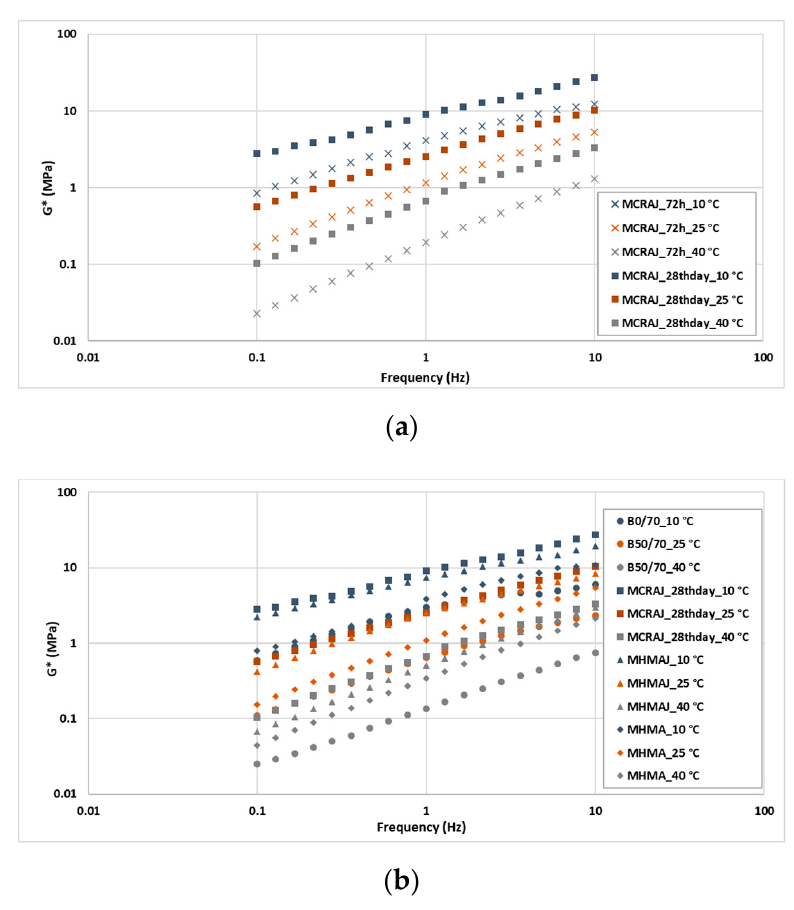
Figure 14. Isothermal plot of shear modulus for comparison between ( a ) CMRAJ by curing time and ( b ) neat bitumen vs. asphalt mastics.